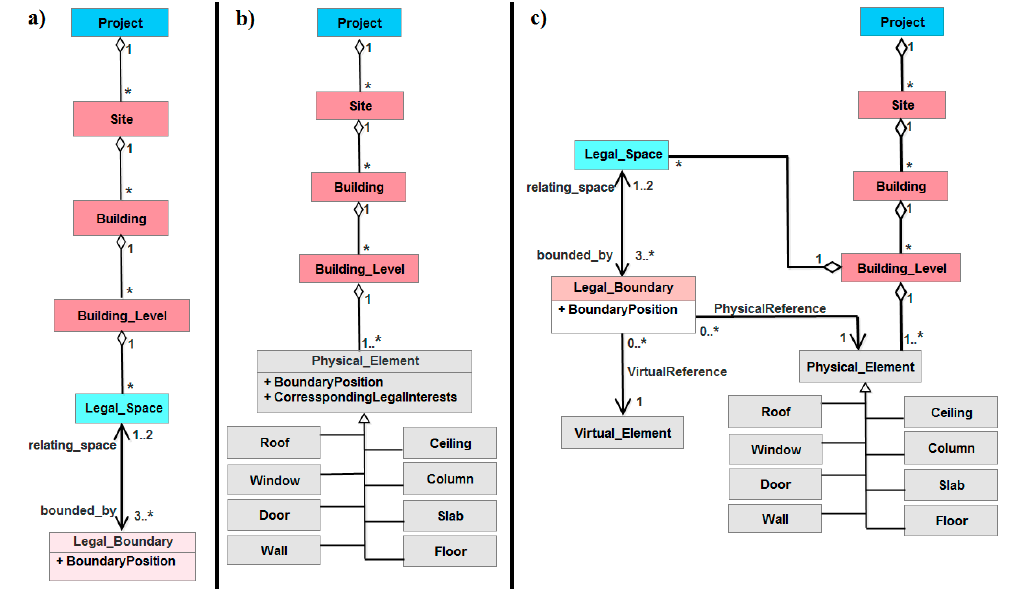
Figure 7. Logical modelling of legal spaces and boundaries in BIM-based views, ( a ) Purely legal view; ( b ) Purely physical view; ( c ) Integrated legal and physical view.